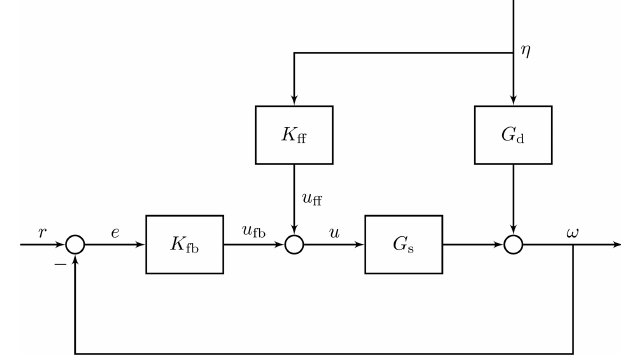
Figure 3. Block diagram of the feedback–feedforward